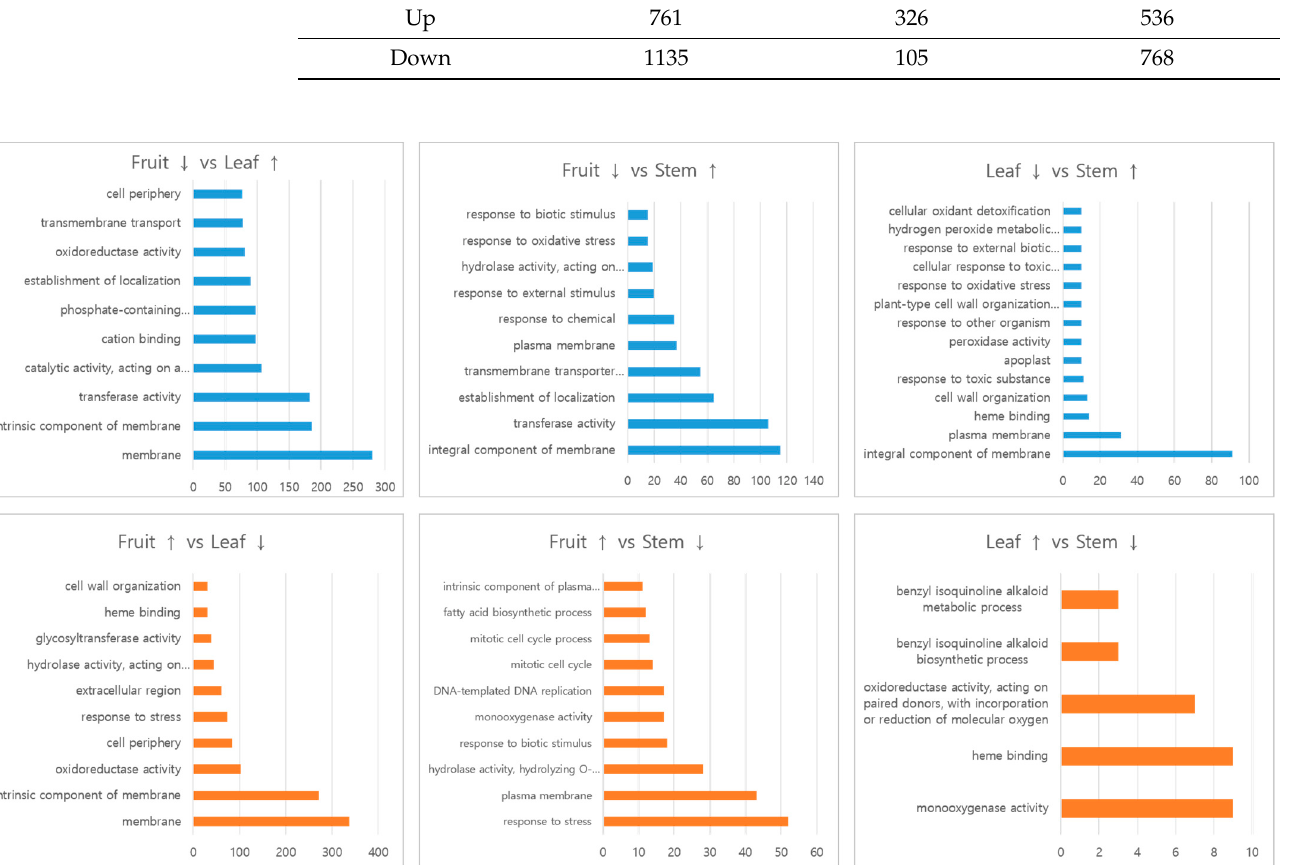
Figure 4. GO analysis of the differently expressed genes between tissues. The numbers in the X -axis represent the number of transcripts.